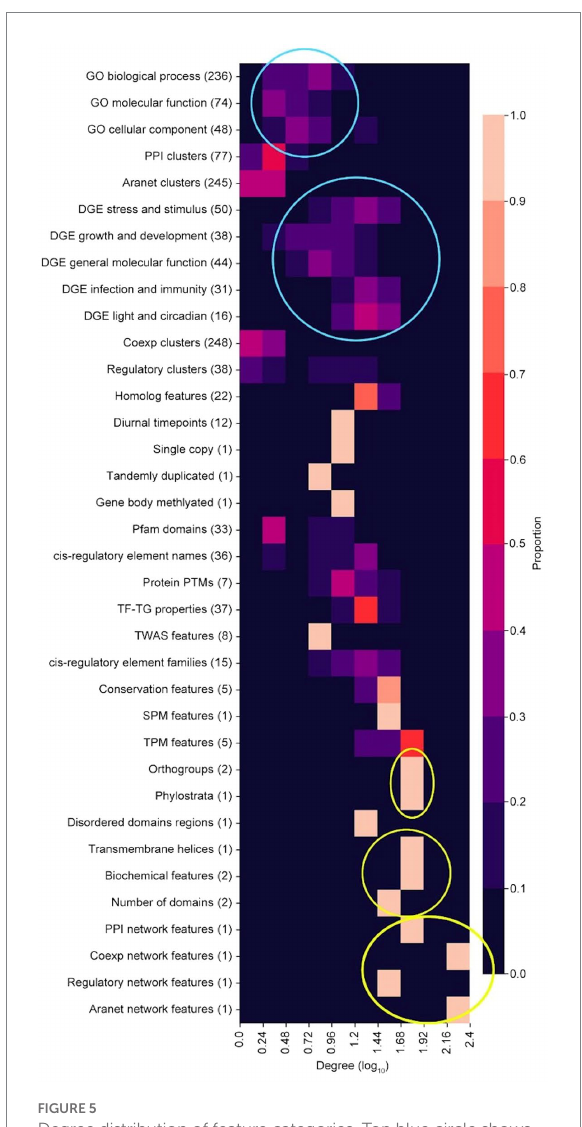
FIGURE 5 Degree distribution of feature categories. Top blue circle shows GO terms while the bottom blue circle shows DGE features. Top yellow circle shows orthogroups and phylostrata, middle yellow circle shows transmembrane helices, biochemical features (length and molecular weight of peptide) and number protein domains, and bottom yellow circle shows network features (cluster size) from the PPI, coexpression, regulatory and Aranet